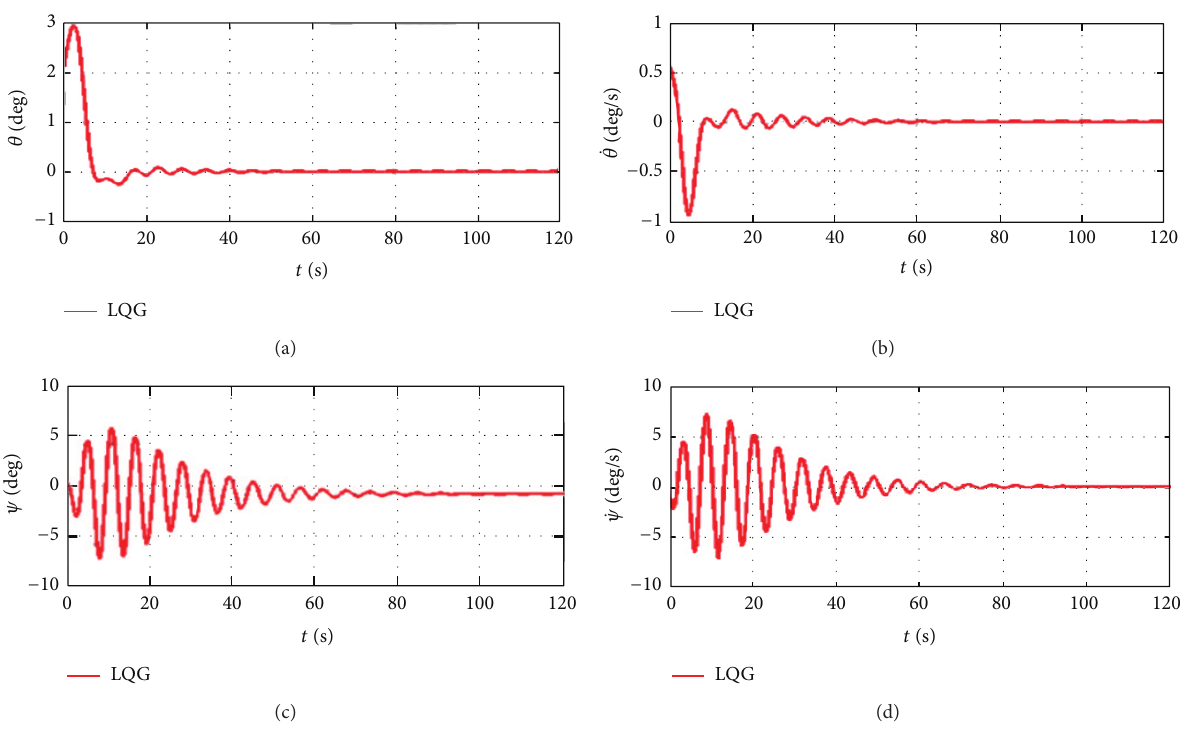
Figure 3: Performance of the LQG control